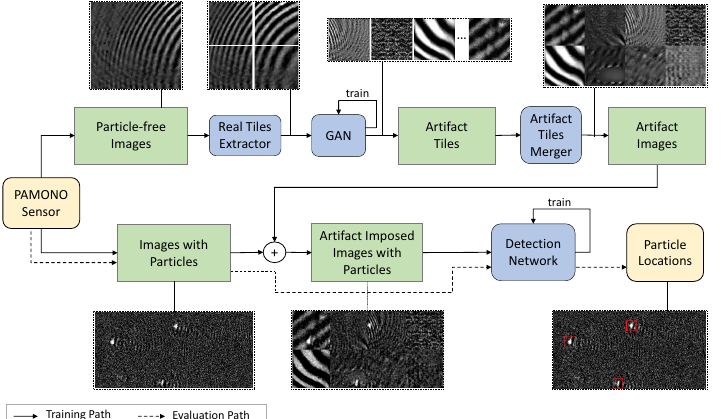
Figure 2. Schematic representation of overlaying training images with generative adversarial net- work (GAN)-generated artifacts from composite tiles. The PAMONO sensor is used to record samples without particles of interest ( upper part ) and samples including such particles ( lower part ) for the training process. The trained detection model is then used to search for particles in images where their presence is unknown. Dashed arrows show the path of images in the evaluation process, while solid arrows represent the path of images in the training process. The images in dotted boxes visualize the single steps by examples. The yellow boxes illustrate start and end of the pipeline, green boxes represent data and blue boxes mark